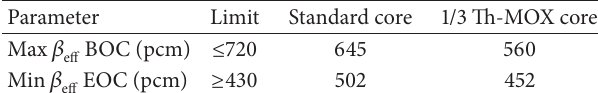
Table 4: Fraction of delayed neutrons.